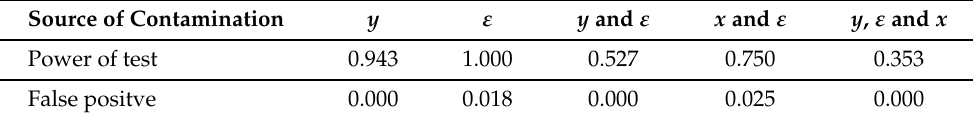
Table 2. Power of test and false positive rate for the SVSOM.